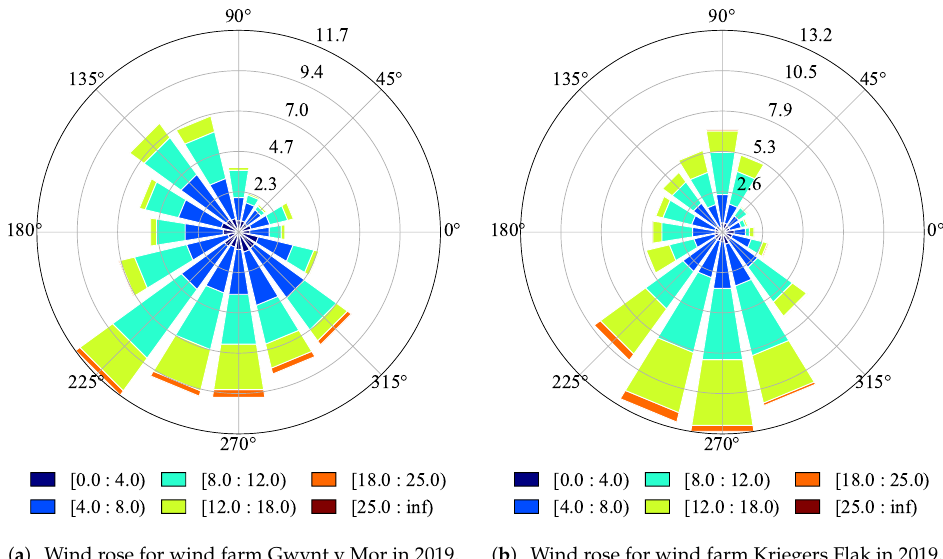
Figure 2. Wind roses for Gwynt y Mor and Kriegers Flak in 2019. Colors, from blue to red, indicate different wind speeds. Corresponding frequencies for each wind angle are displayed by the length of